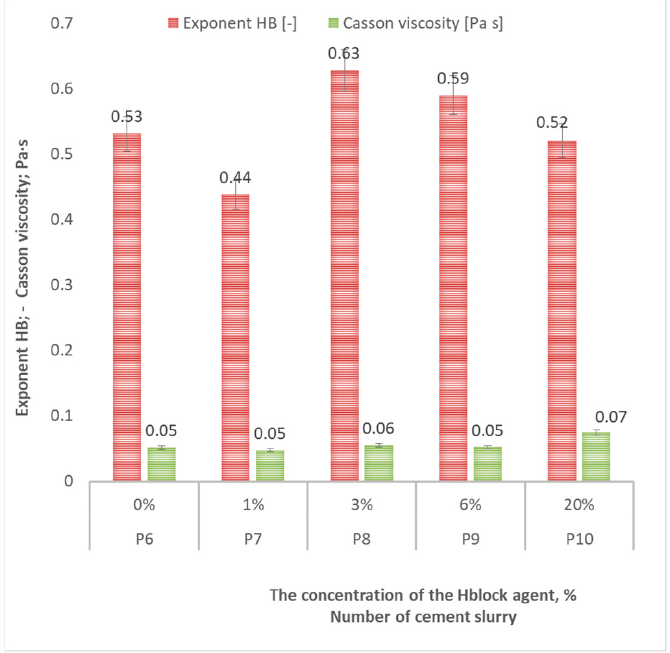
Figure 17. Summary of selected test results for rheological parameters of cement slurries (cement class CEM G).